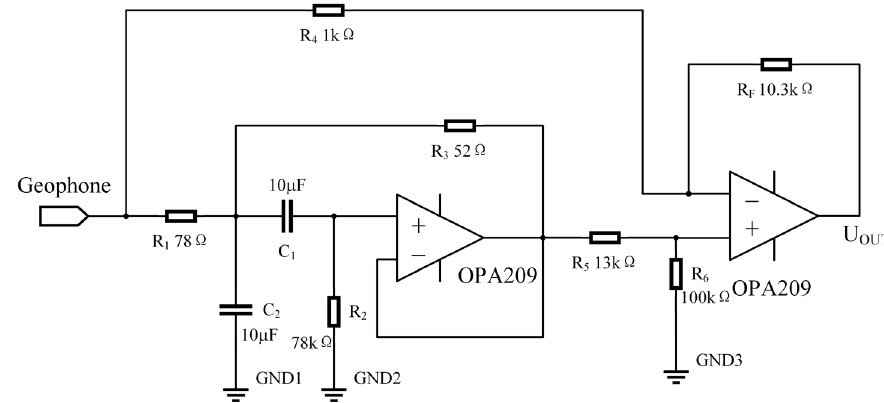
Figure 5. New method correction circuit diagram.